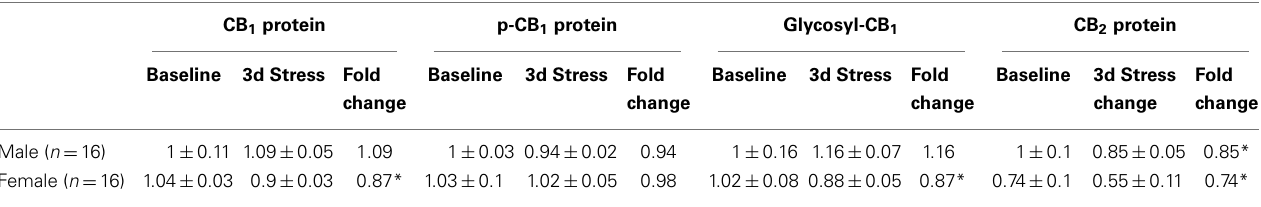
Table 2 | Relative fold change (mean ± SD) in CB 1 and CB 2 protein expression levels in the prefrontal cortex of male adolescent rats after 3days repeated inescapable repeated tail-shock stress and female